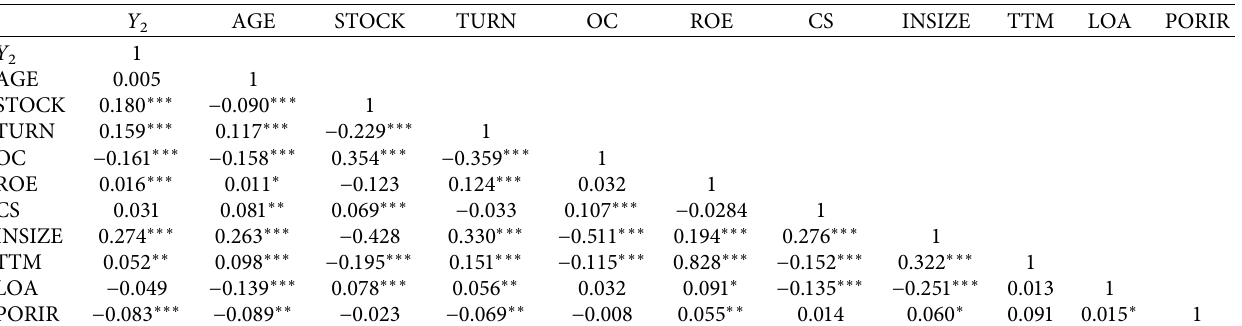
Table 5: Correlation results of the main variables that affect the investment amount